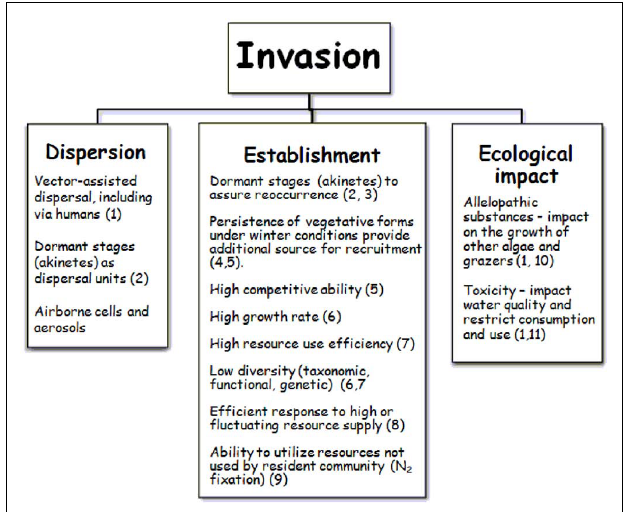
FIGURE 2 |Traits and process that support the invasiveness of cyanobacteria according to its three major components: dispersion, establishment, and ecological impact. References (1) Neilan et al., 2003; (2) Kaplan-Levy et al., 2010; (3)Wiedner et al., 2007; (4) Suikkanen et al., 2010; (5) Rücker et al., 2009;(6) Padisák, 1997; (7) Isvánovics et al., 2000; (8) Posselt et al., 2009; (9) Hadas et al., submitted; (10) Bar-Yosef et al.,